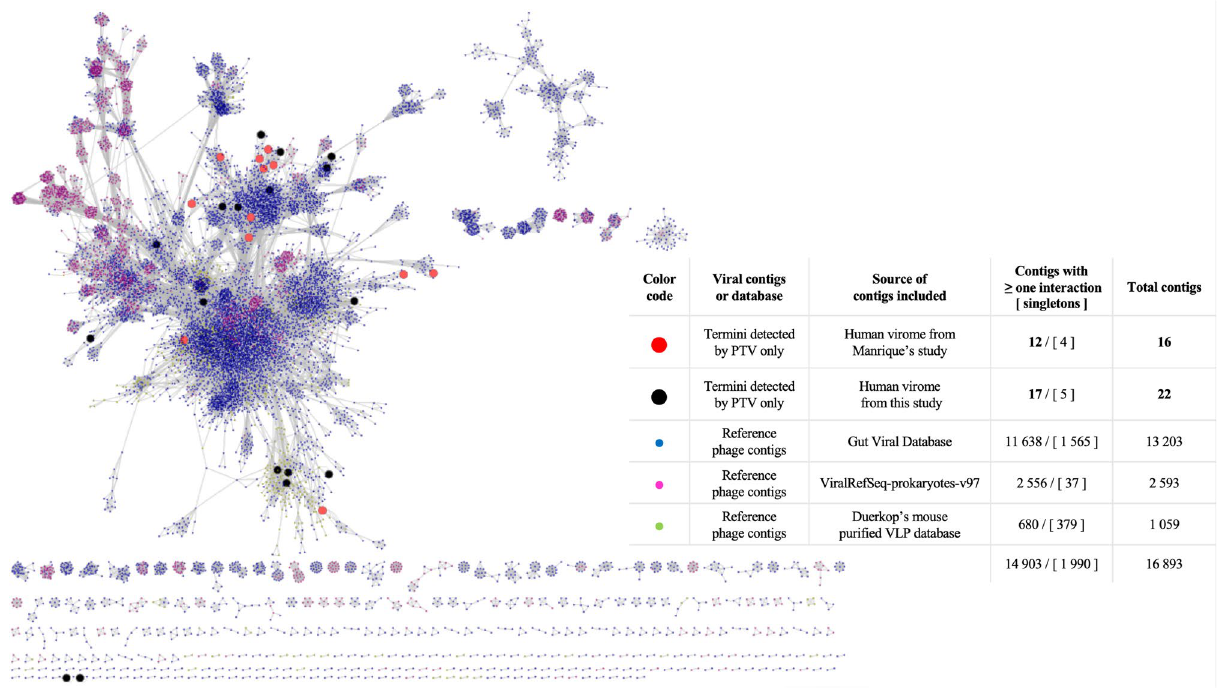
Figure 4. Viral cluster analysis with vConTACT2 using a gene-sharing network. The large red dots represent phage contigs (Manrique dataset) for which PTV predicted a terminus and packaging mode but not predicted to be viral by MetaPhinder, Phaster, or VirSorter. The large black dots represent phage contigs (dataset from this study) for which PTV predicted a terminus and packaging mode but not predicted to be viral by MetaPhinder, Phaster, or VirSorter. Network analysis was performed using three reference contig collections: GVD 8 , ViralRefSeq V.97 41 , and a database of curated virus-like particles from mice 42